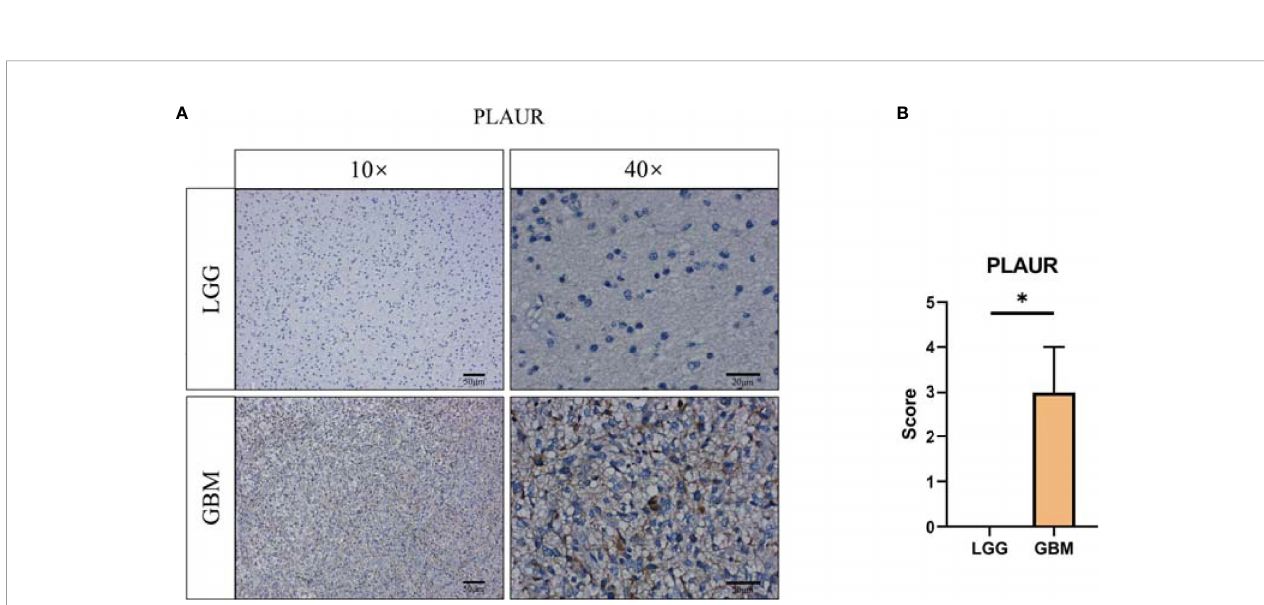
FIGURE 10 | Validation of prognostic gene expression. (A) Immunohistochemical staining and (B) statistical analysis of PLAUR protein level between LGG (n = 3) and GBM (n = 3). *, p <